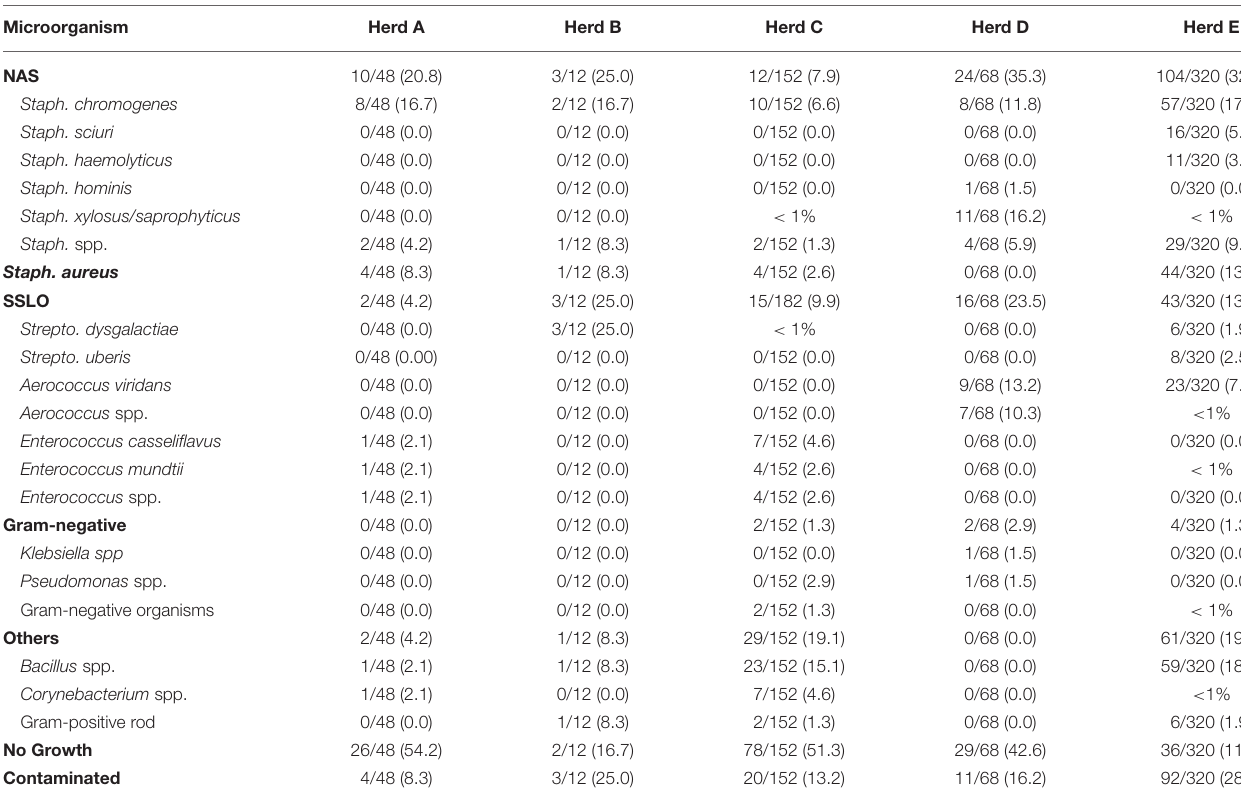
TABLE 2 | Prevalence (%) of microorganisms identified in 600 quarter milk samples submitted for culture. Microorganism Herd A Herd B Herd C Herd D Herd E